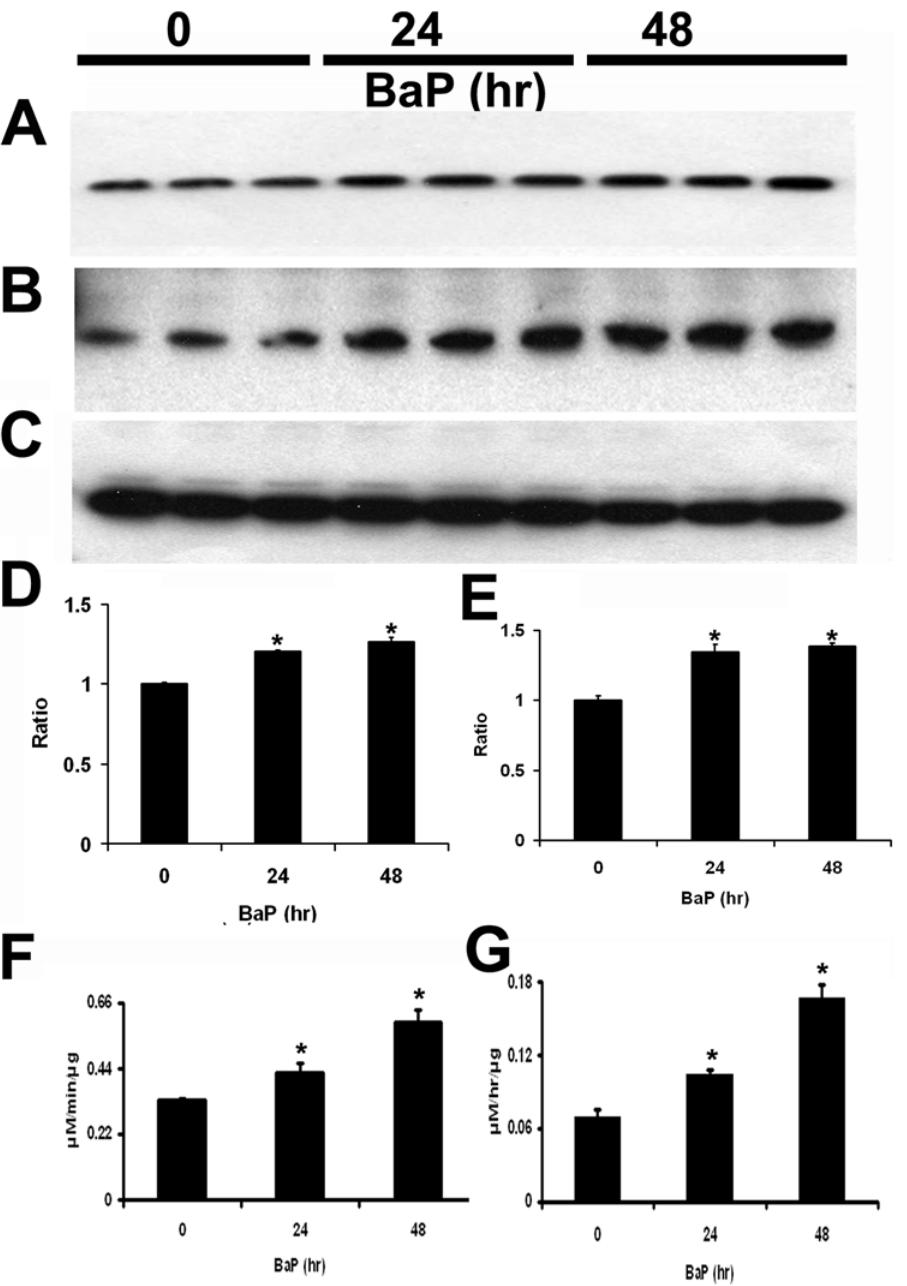
Figure 4. Lysosomal enzyme activity. (A–C) Comparison of protein levels of cathepsin D (A) and b -glucuronidase (B) in ARPE-19 cells by immunoblots. b -actin was used as a loading control (C). (D) Expression of cathepsin D in ARPE-19 cells. The differences in protein levels of cathepsin D were determined by scanning gels and determining the integrated areas of the bands using Image-J software. Data are expressed as normalized ratios to actin. Appropriate background subtraction and normalization of the data to actin was done for each blot. Values are the mean 6 SEM. There were significant increases in cathepsin D protein following 10 m M B(a)P treatment for 24 hr and 48 hr (p , 0.05, n=3), compared to untreated controls. Data were expressed as normalized ratios to actin. (E) Expression of b -glucuronidase in ARPE-19 cells. The differences in expression levels of b -glucuronidase were determined by scanning gels and determining the integrated areas of the bands using Image-J software. Data are expressed as normalized ratios to actin. Appropriate background subtraction and normalization of the data to actin was done for each blot. Values are the mean 6 SEM. There were significant increases in b -glucuronidase protein following 10 m M B(a)P treatment for 24 hr and 48 hr (p , 0.05, n=3), compared to untreated controls. (F) Cathepsin D enzymatic activity from cell extracts were significantly increased at 10 m M B(a)P treatment ( p , 0.05, n=3). ( G ) b -glucuronidase enzymatic activity from cell extracts was significantly increased at 10 m M B(a)P treatment ( p , 0.05, n=3).